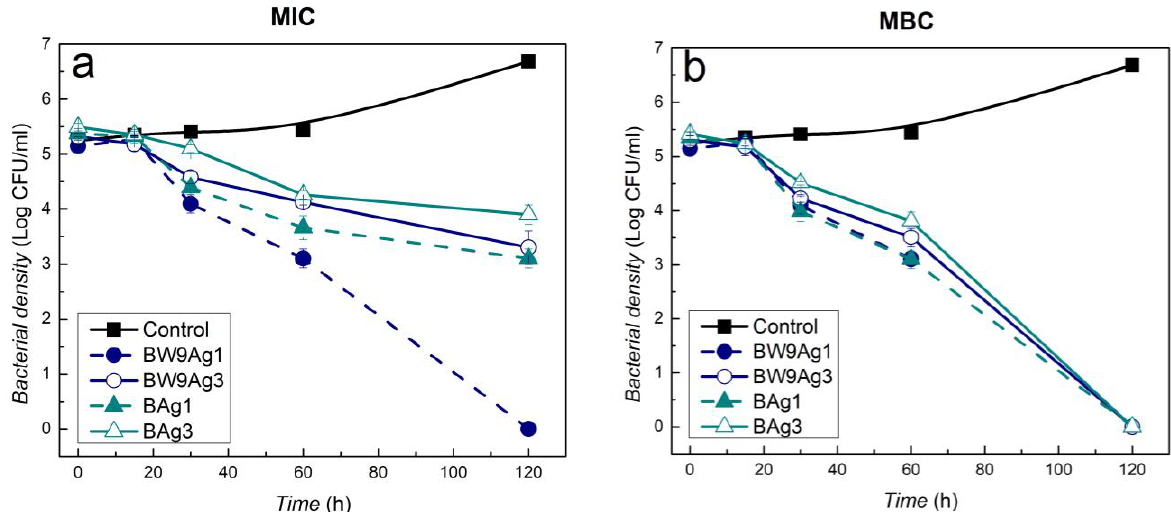
Figure 6. Time–kill kinetics for E. coli exposed to ( a ) MIC and ( b ) MBC concentrations of nanocom- posites synthesized after 120 minutes’ reaction time using precursors BW9 and B at 25 ◦ C (BW9Ag1 and BAg1) and 80 ◦ C (BW9Ag3 and